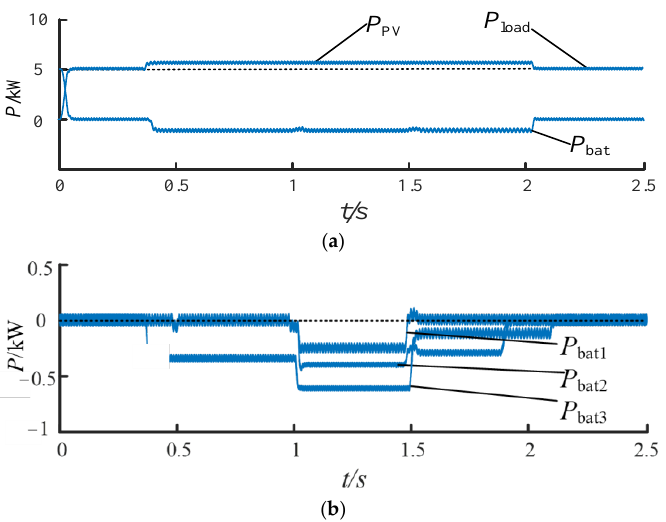
Figure 9. ESU exceeds the limit simulation results. ( a ) Photovoltaic unit, load, and DESS power. ( b ) ESU output power.